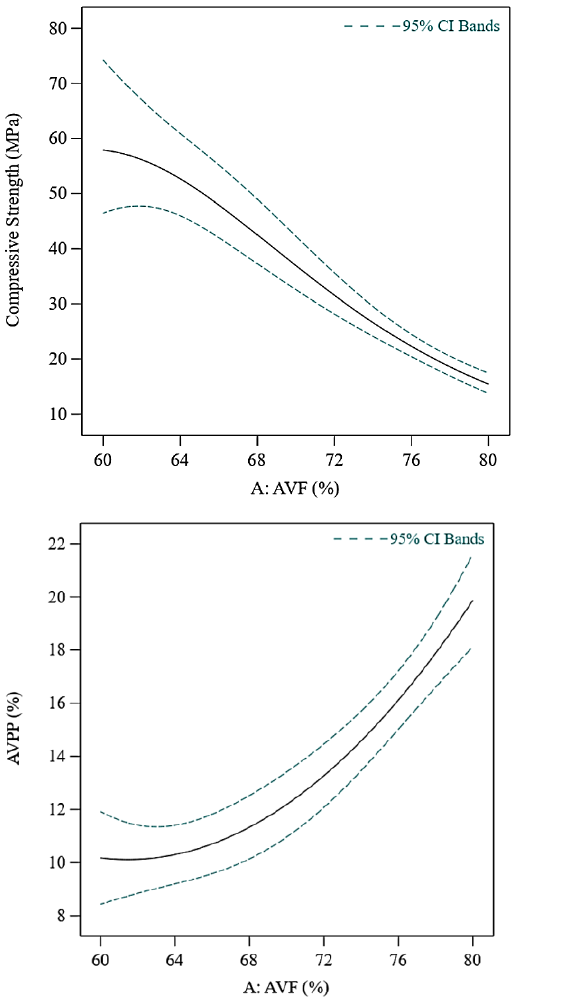
Figure 2. The flowchart of the research processes.